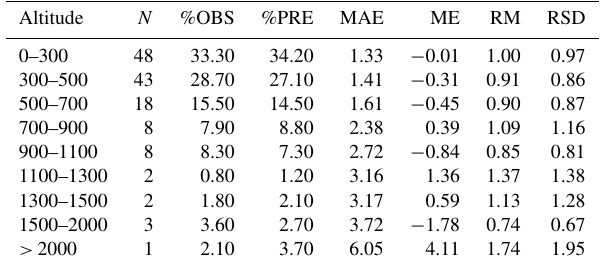
Table 2. The leave-one-out cross-validation (LOO-CV) statistics showing the goodness of fit between measurements and estimations of daily precipitation separated by altitudes (ma.s.l.). N : number of stations; %OBS: percentage of observed precipitation; %PRE: per- centage of predicted precipitation; MAE: mean absolute error; ME: mean error; RM: ratio of means; RSD: ratio of standard deviations. The results were rounded to two decimal places.